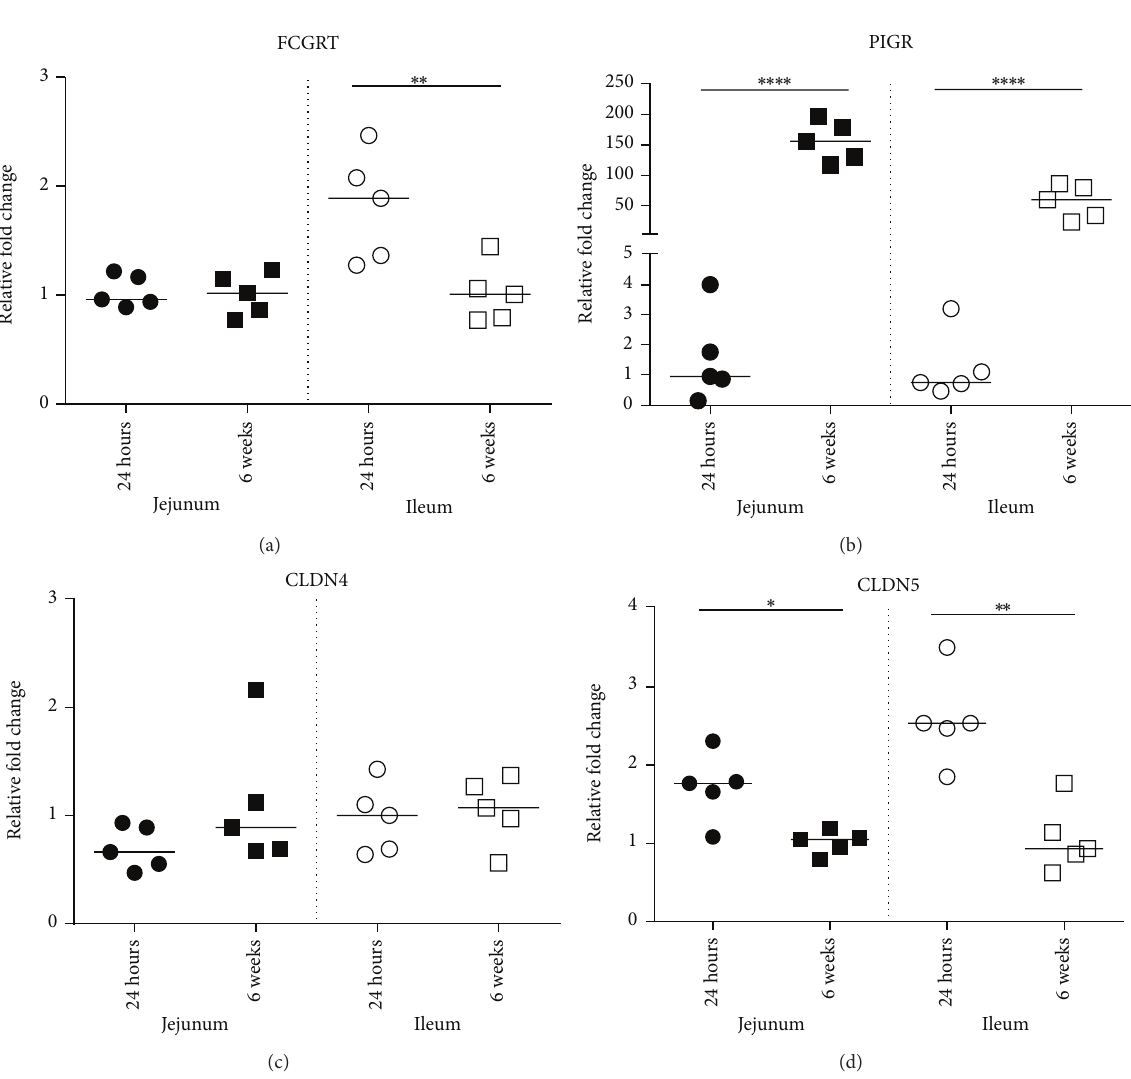
Figure 1: QPCR analysis of CLDN4 and CLDN5 expression in jejunal and ileal gut tissue. The mRNA expression levels of FCGRT, PIGR, CLDN4, and CLDN5 genes were normalized with the reference genes and were calculated with 2 −ΔΔ Ct relative quantification. Dots show the data for each biological replicate ( 𝑛 = 5 per group). Horizontal bars represent the median values ( ∗ 𝑃 < 0.05 ; ∗∗ 𝑃 < 0.01 ; ∗∗∗∗ 𝑃 < 0.0001